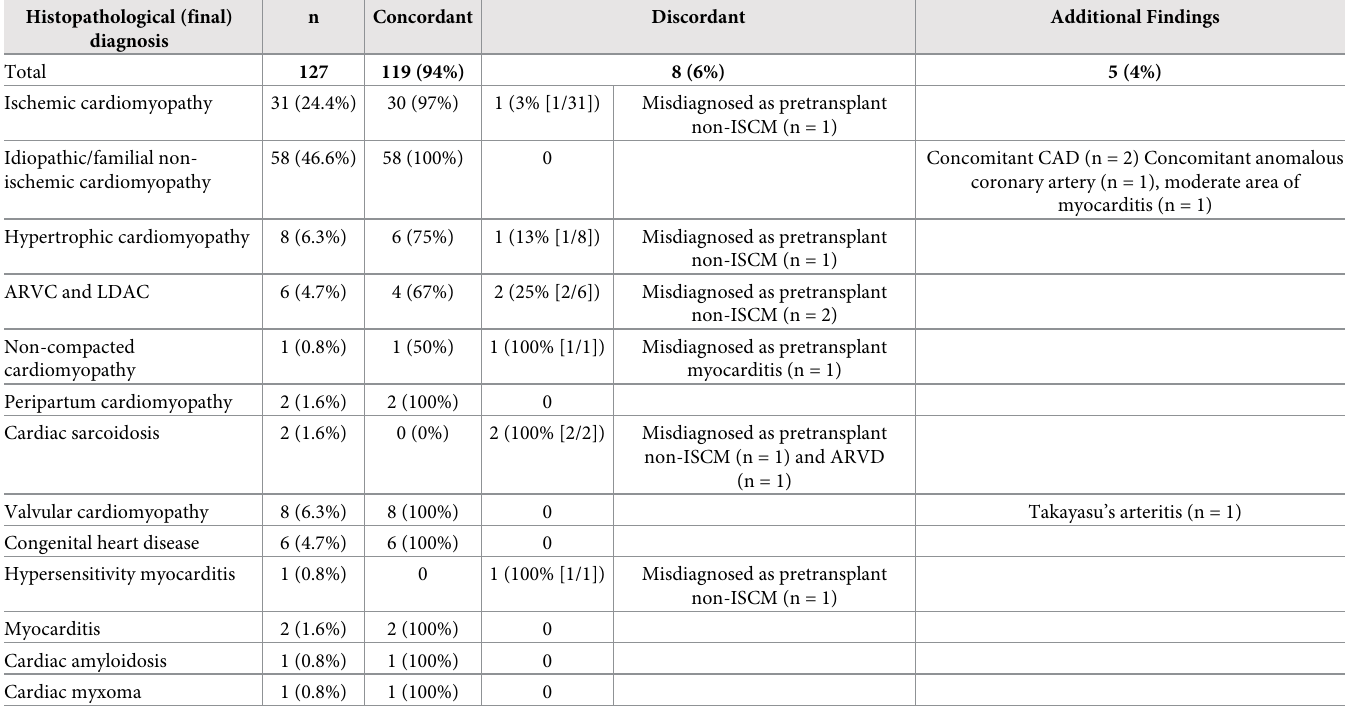
Table 2. Histopathological diagnoses of the entire cohort.